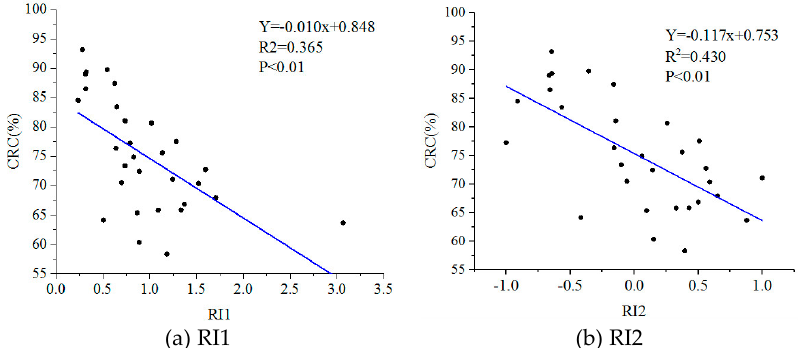
Figure 5. Regression between CRC and some radar parameters.